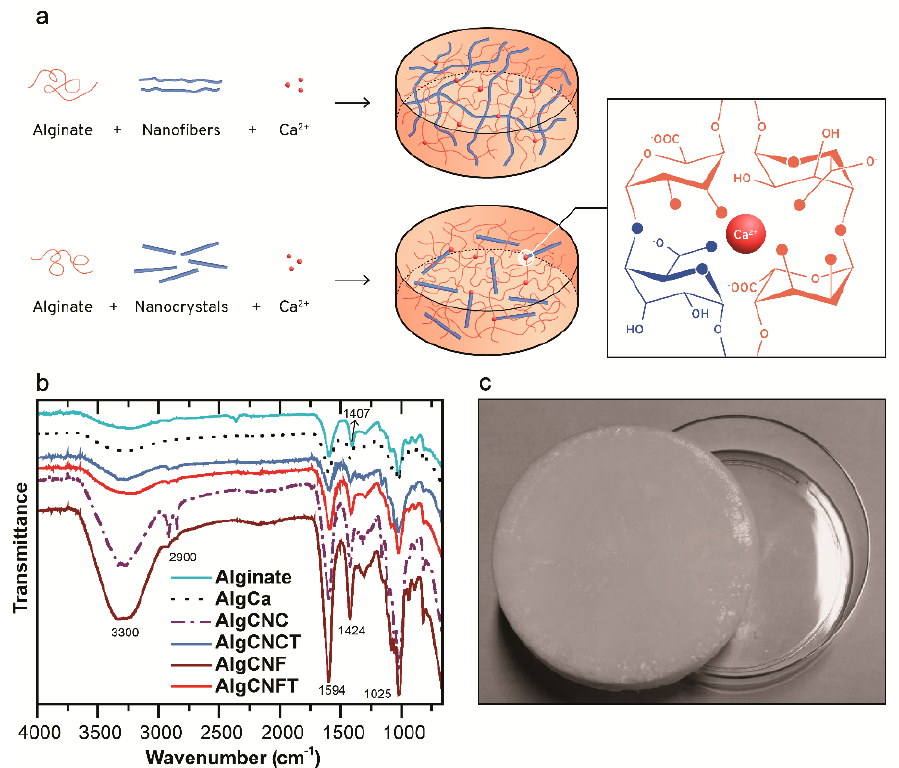
Figure 2. Formulation and characterization of nanocellulose-alginate based hydrogels. ( a ) Schematic representation of the crosslinking reaction of alginate gels and TEMPO-oxidized nanocellulose with Ca 2+ ions. ( b ) FTIR spectra of the pure sodium alginate polymer (starting material), the pure alginate gel (AlgCa) and the nanocellulose alginate gels at 36 wt % of nanocelluloses (AlgCNC36, AlgCNCT36, AlgCNF36, AlgCNFT36). ( c ) Digital image of the gel AlgCNFT36.